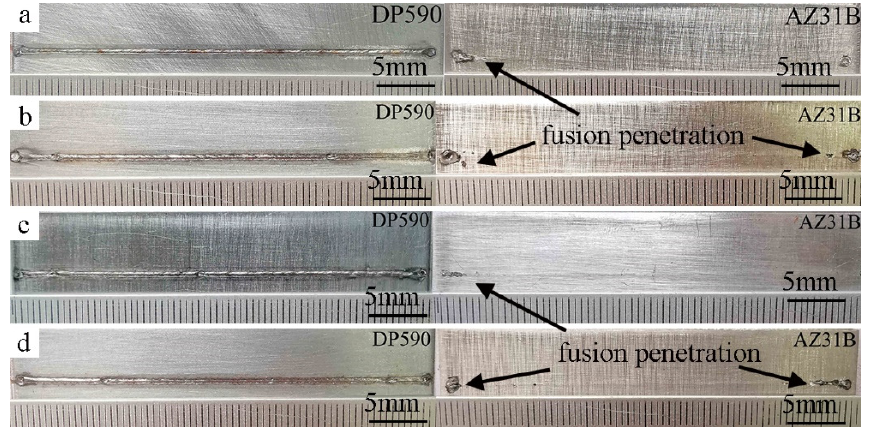
Figure 3. Weld surface morphology of joint: ( a ) Cu − 0%Si, ( b ) Cu − 2%Si, ( c ) Cu − 5%Si, and ( d ) Cu − 8%Si.